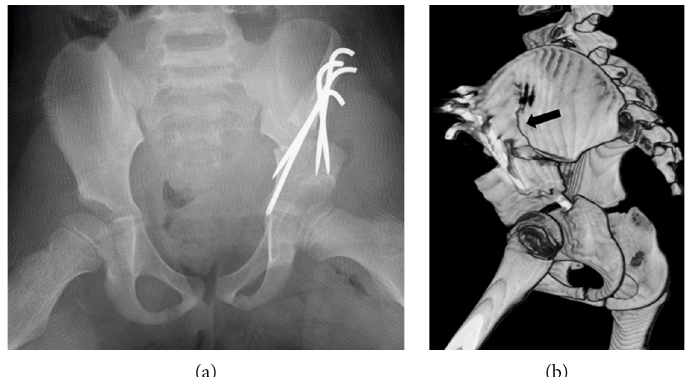
Figure 3: (a) The radiograph at two days after Salter innominate osteotomy. (b) 3D CT image indicating iliac fracture between the osteotomy site and iliac crest (black arrow).